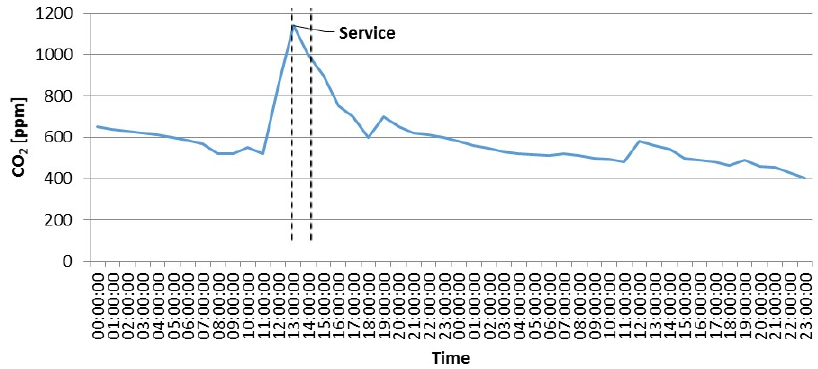
Figure 10. CO 2 concentration in the church during the summer period.